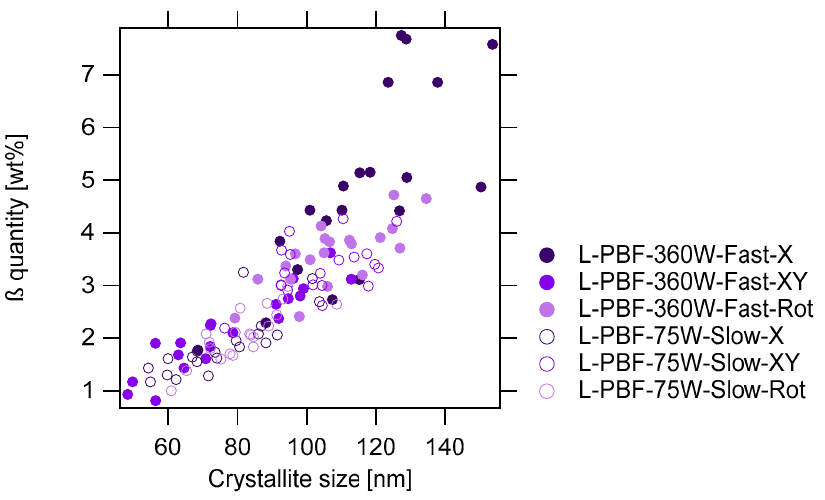
Figure 6. Crystallite size of the α or α ’ phase versus c / a of the α or α ’ phase scatter plot for all L-PBF and EB-PBF parts. A correlation between the crystallite size and c / a , and the separation of the L-PBF and EB-PBF data points are seen.